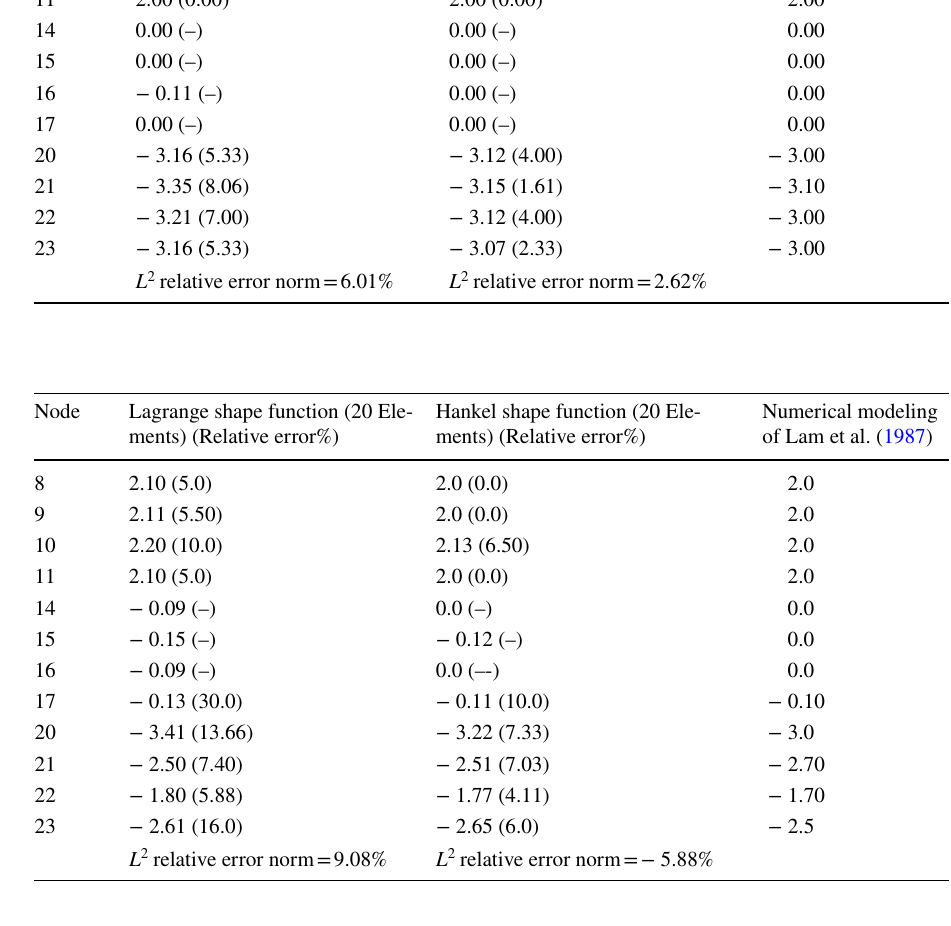
Node Lagrange shape function (20 ele- results obtained from Hankel ments) (relative error%) shape function, Lagrange shape function and numerical solution of Lam et al. (1987) t = 22.5 min at for the fifth problem